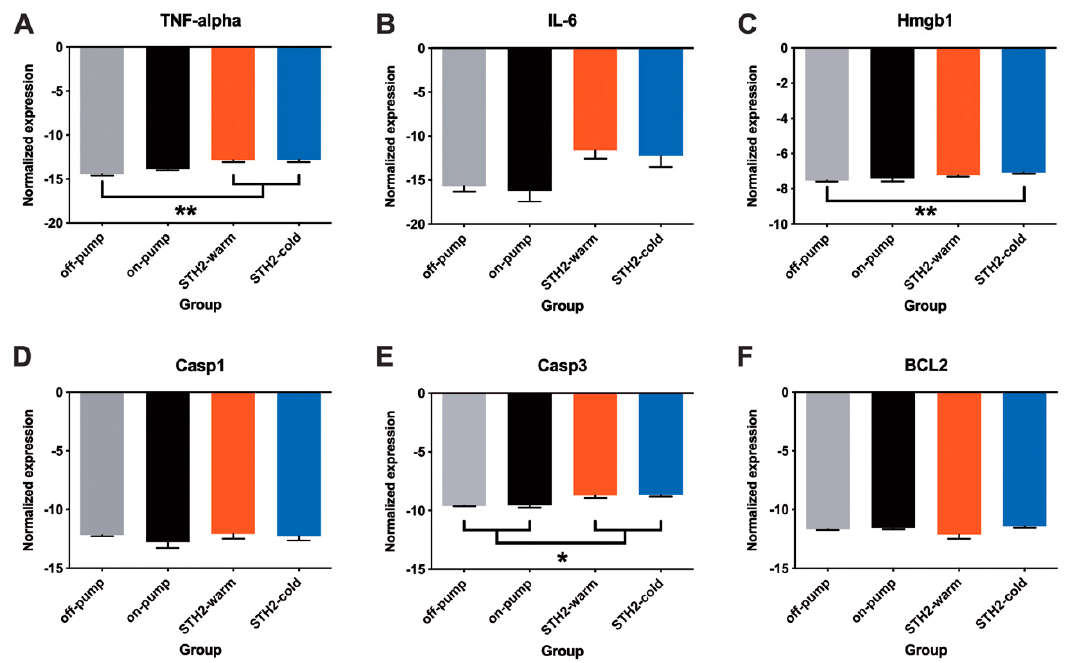
Figure 8. Expression of pro-inflammatory cytokines and apoptotic markers within the myocardium. ( A ) mRNA expression of Tnf- α , ( B ) IL-6, ( C ) Hmgb1, ( D ) Casp3, ( E ) Casp1 and ( F ) Bcl2 within left ventricular tissue samples in all experimental groups. Values are mean ± SD, n = 5–6/group. IL-6: Interleukin-6, Tnf- α : Tumour Necrosis Factor alpha; Hmgb1: High mobility group box protein 1, Casp1: Caspase 1 and Casp3: Caspase 3. * = p < 0.05, ** = p < 0.01.